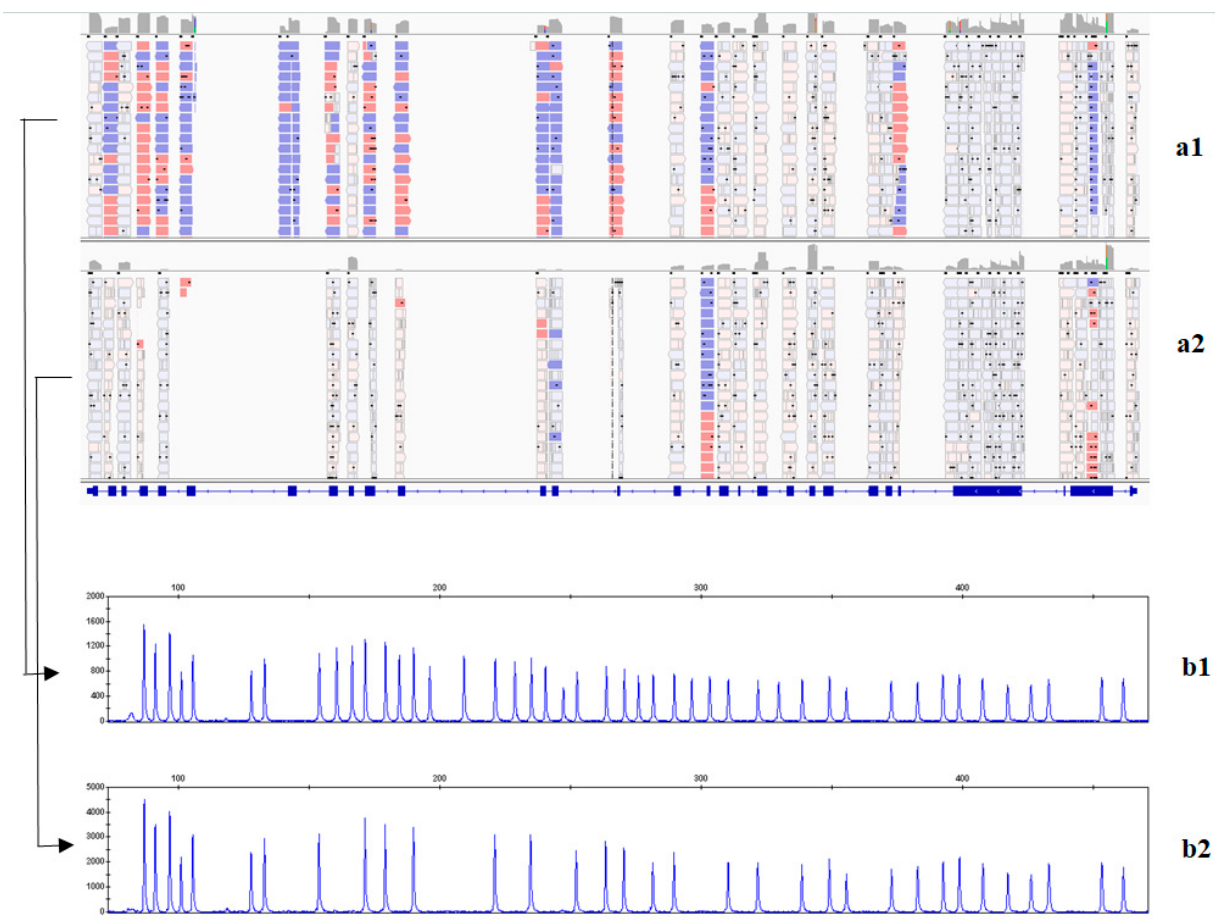
Figure 1. The detection of biallelic gross deletions of the STRC gene. ( a ) Using IGV genomic browser, ( b ) using MLPA, ( a1 , b1 )—normal, ( a2 )—no reads aligned with the STRC gene sequence, ( b2 )— STRC, CKMT1B, CATSPER2 deletions in the homozygous state.